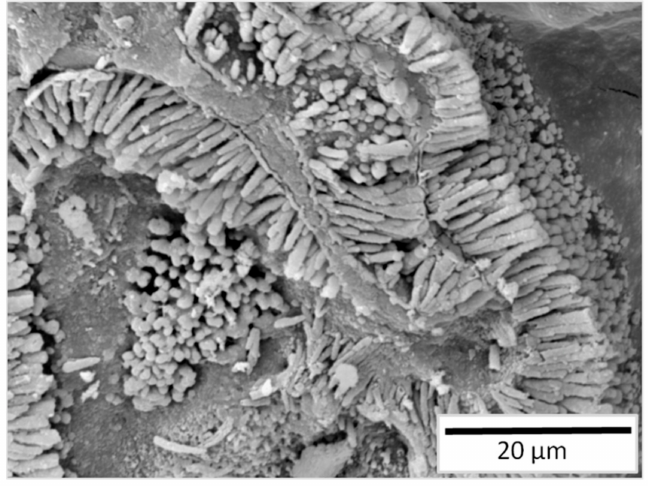
Figure 8. SEM image: biofilm and tubular crystals of